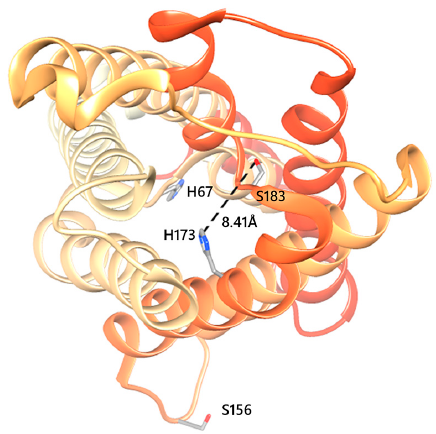
Figure 2. Structure of human AQP5 monomer. Top view of AQP5 monomer with phosphorylation consensus sites Ser156 localized in intracellular loop D, and Ser183 localized in the selectivity filter along with His173. As proposed, when His67 side chain rotates outside the pore, it allows water passage through the pore (open state) [24]. In such cases, if the proximity of His173 to Ser183 (D1) is 7Å<D1<10Å, the AQP5 monomer shows a wide conformation. Structures were generated with